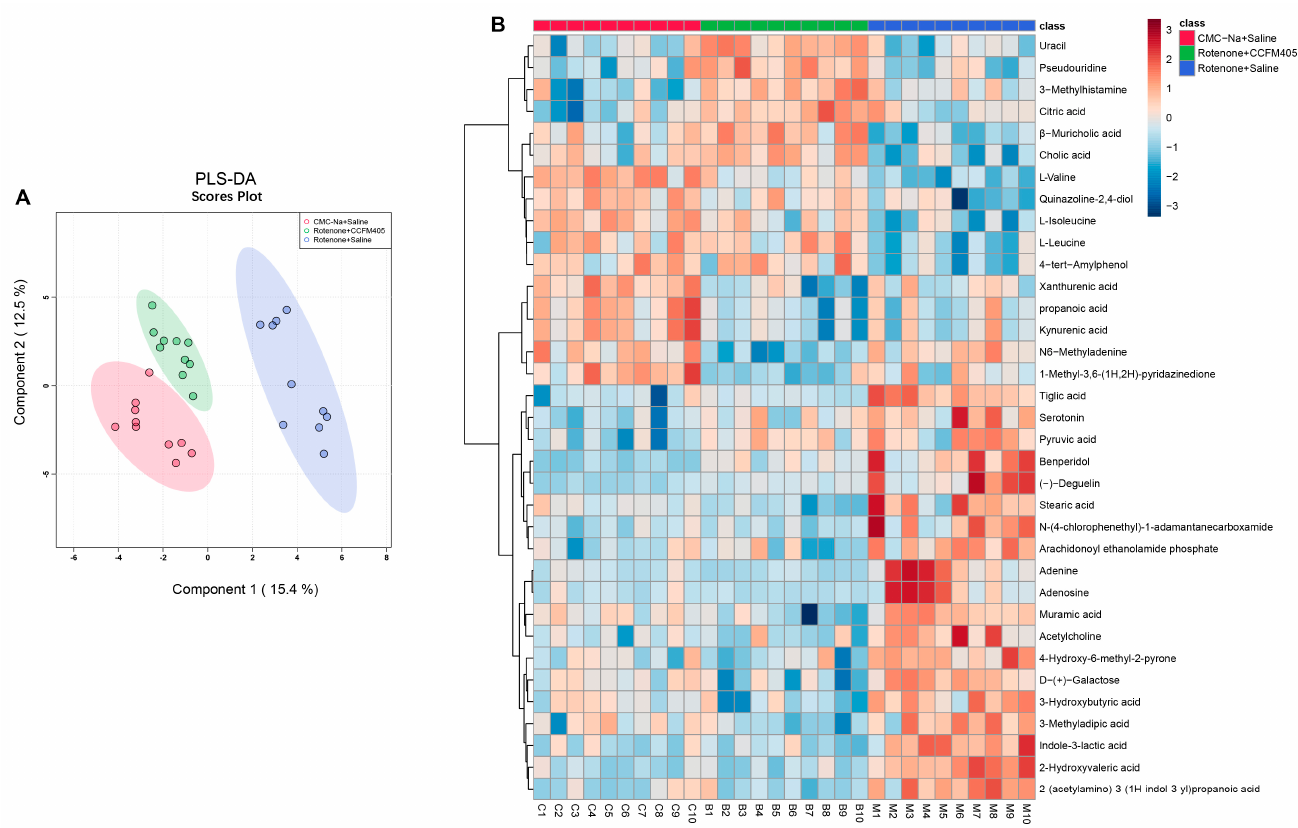
Figure 11. The PLS-DA model analyzed the composition of serum metabolites in each group of mice. ( A ) Two-dimensional score plot of serum metabolites PLS-DA in the three groups of mice; ( B ) cluster heat map of the top 30 differential metabolites ranked significant by one-way ANOVA in the three groups of mice, n = 10/group.